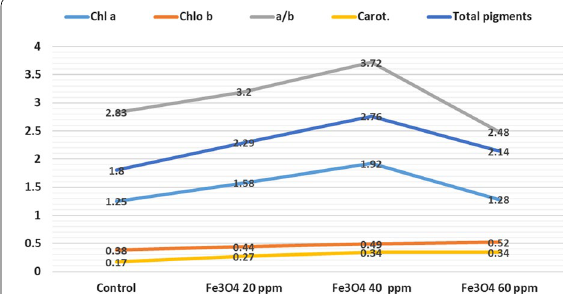
Fig. 1 Effect of foliar application with Fe 3 O 4 NPs on photosynthetic pigments (mg/g 100 fresh wt) content of Moringa oleifera L. (LSD 5% chl a 0.13, chl b 0.03, chl a/b 0.36, carot 0.02 and total = = = = pig 0.27) =